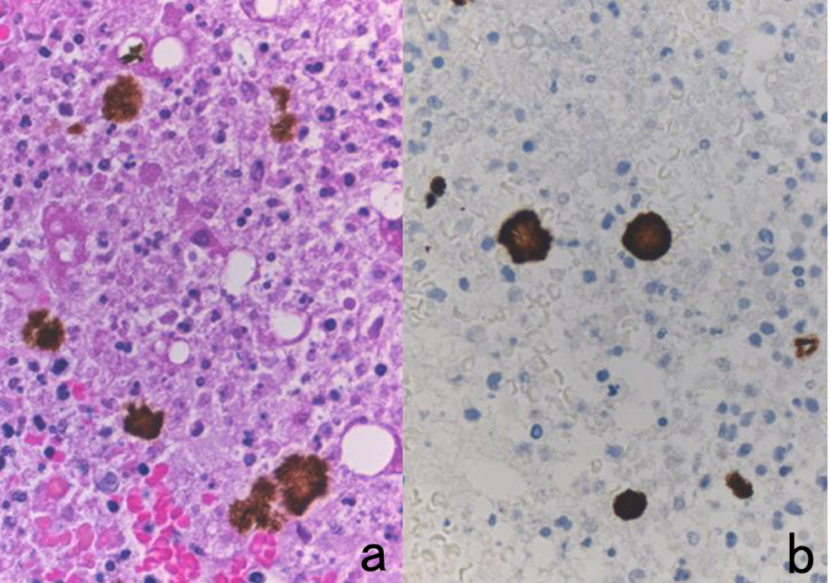
Figure 22. Concentrated bile pigments in a cell block preparation of liver abscess clinically suspected of being amebic infection. ( a ): H&E and ( b ): immunostaining using a monoclonal antibody EHK153 against Entamoeba histolytica . Brown-colored structures of concentrated bile pigments somewhat resemble strongly immunoreactive amebic trophozoites. The entamoeba antigen must be judged as negative in this case. Careful comparison with H&E histology is needed to avoid falsely judging these as positive immunohistochemical